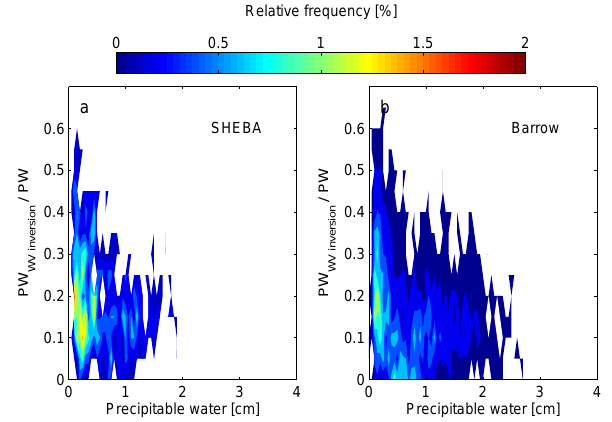
Fig. 11. The RFDs of maximum WV inversion structure PW (PW WVInversion ) normalized by the total column PW as a function total column PW (in cm) for (a) SHEBA (b) Barrow radiosounding